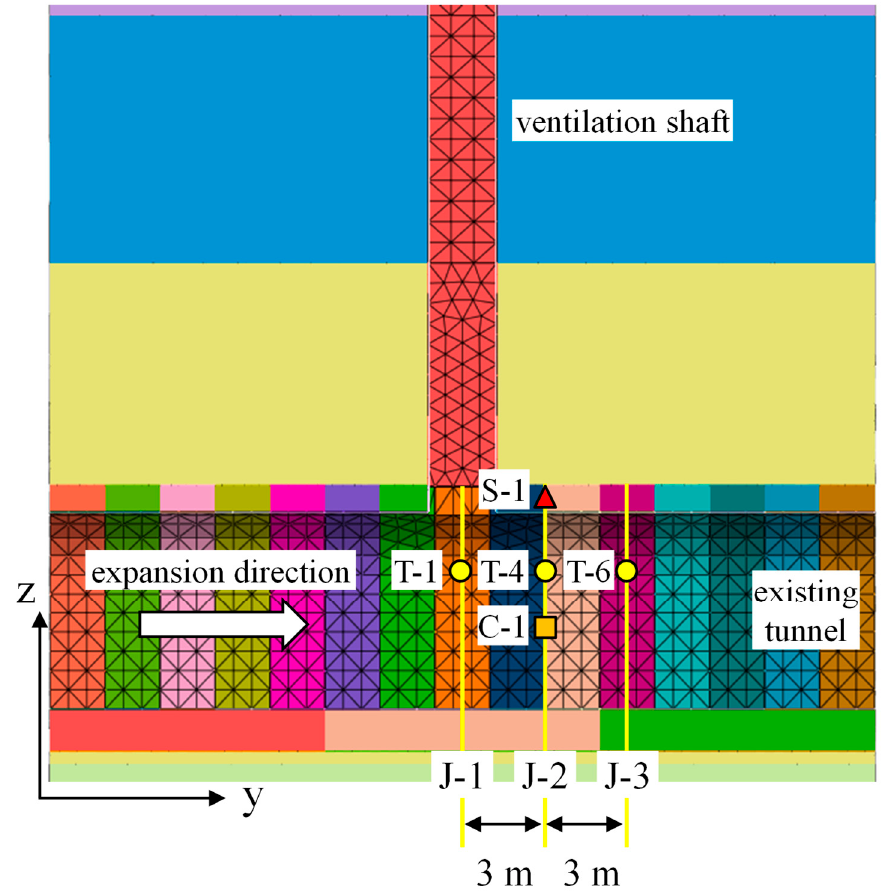
Figure 9. Feature points of FEA.